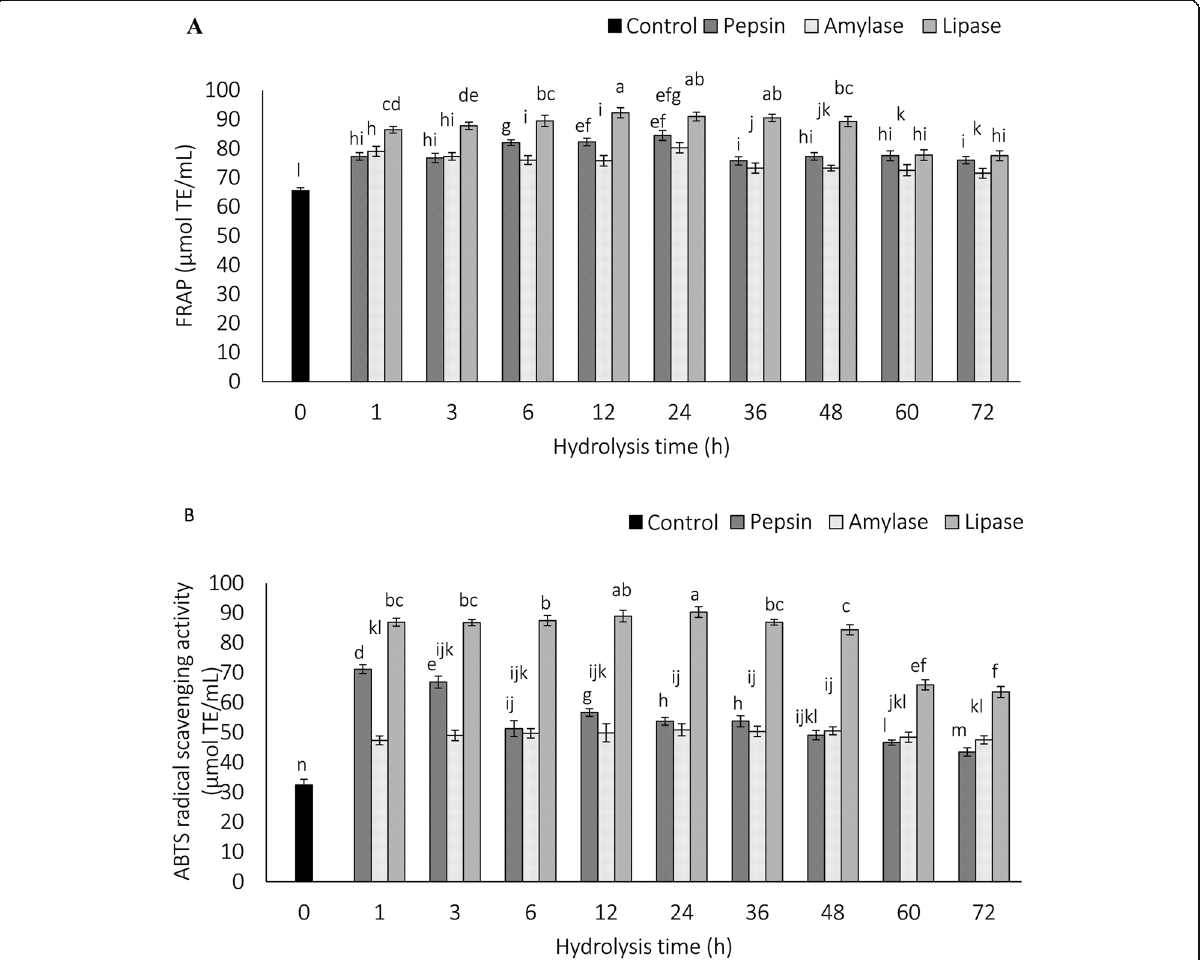
Fig. 2 FRAP ( a ) and ABTS radical scavenging activity ( b ) of chitooligosaccharides (COSs) from squid pen prepared using pepsin or amylase or lipase for diffeent hydrolysis times. Bars represent the standard deviation ( n = 3). Enzymes at 8% (w/w) were used. Different lowercase letters on the bars indicate significant difference ( p < 0.05)